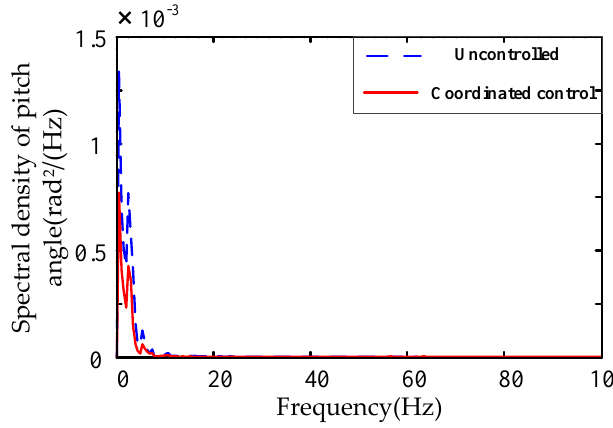
Figure 26. Vehicle roll angle under the steering condition.